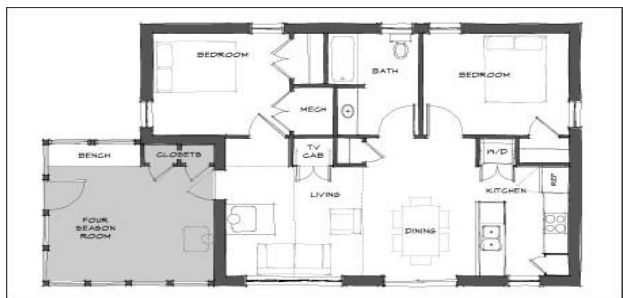
Figure 4. Mini House Floor